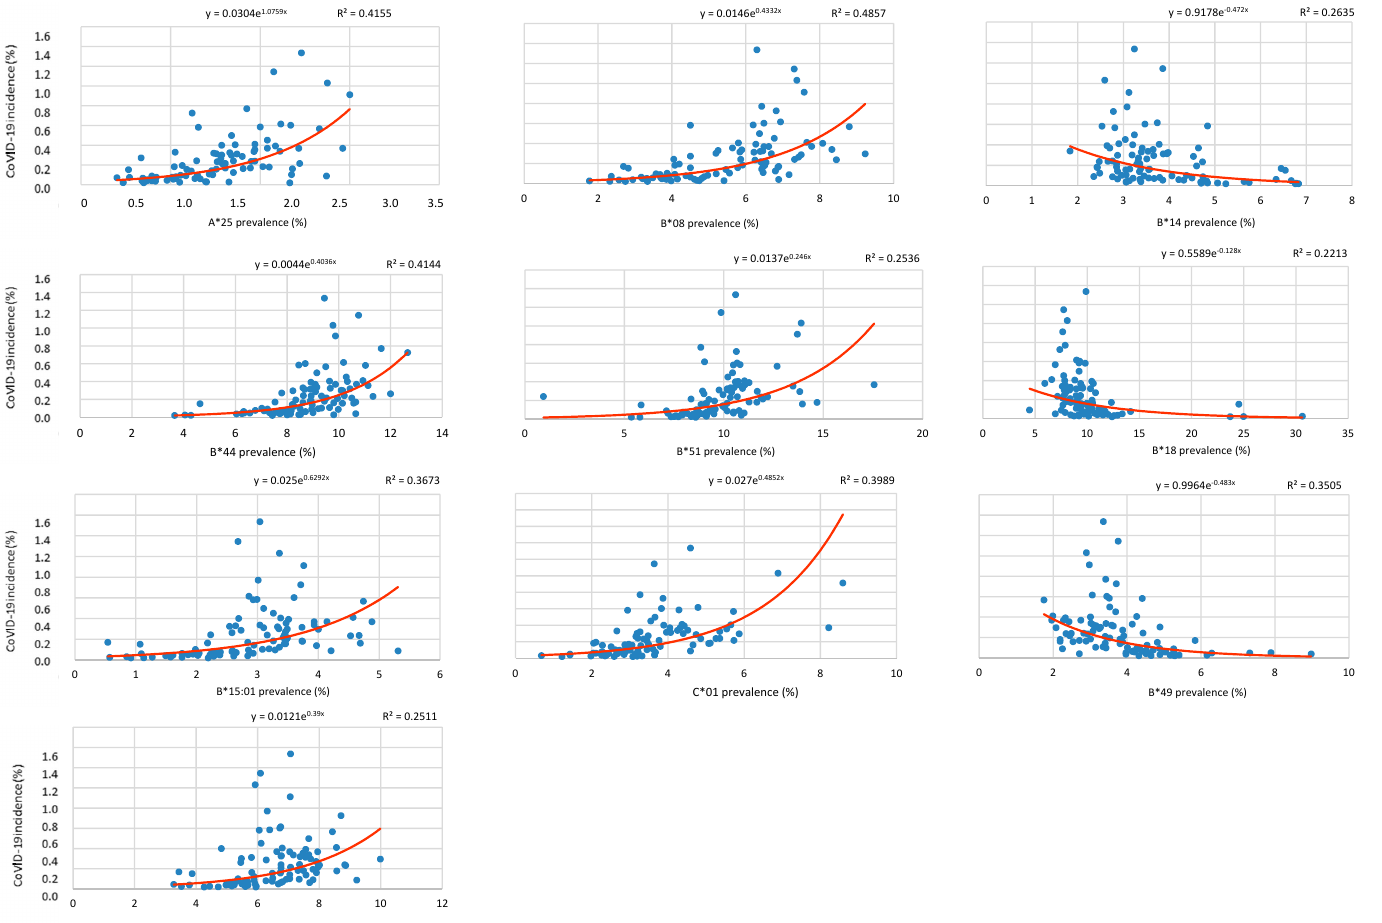
Figure 2 – Correlation between Covid-19 incidence rate and HLA prevalence